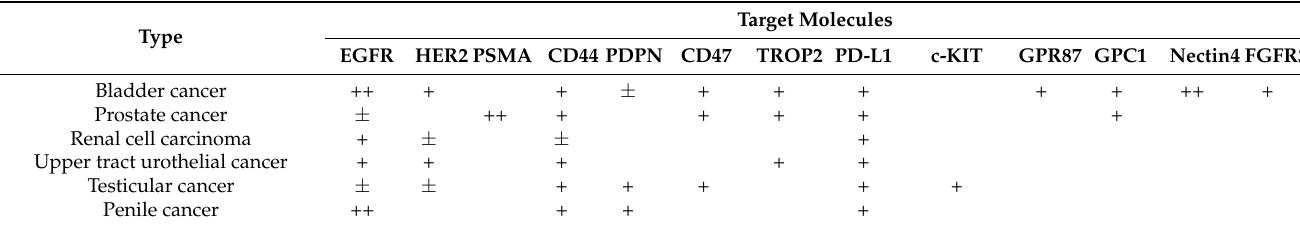
Table 1. Candidate target molecules for urologic cancers in cancer cell-targeted NIR-PIT.